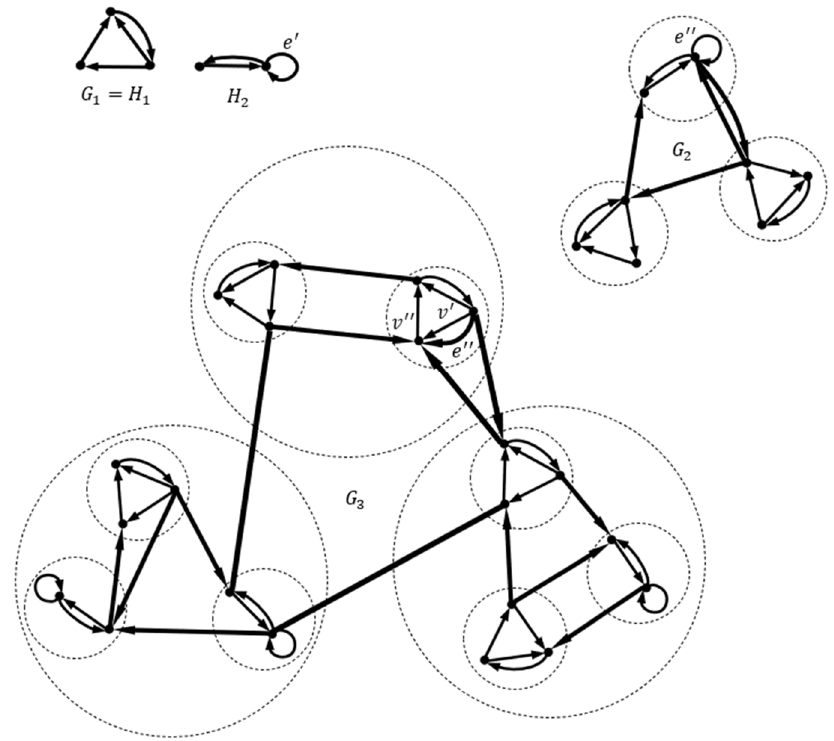
Figure 8. Oriented multigraph G 3